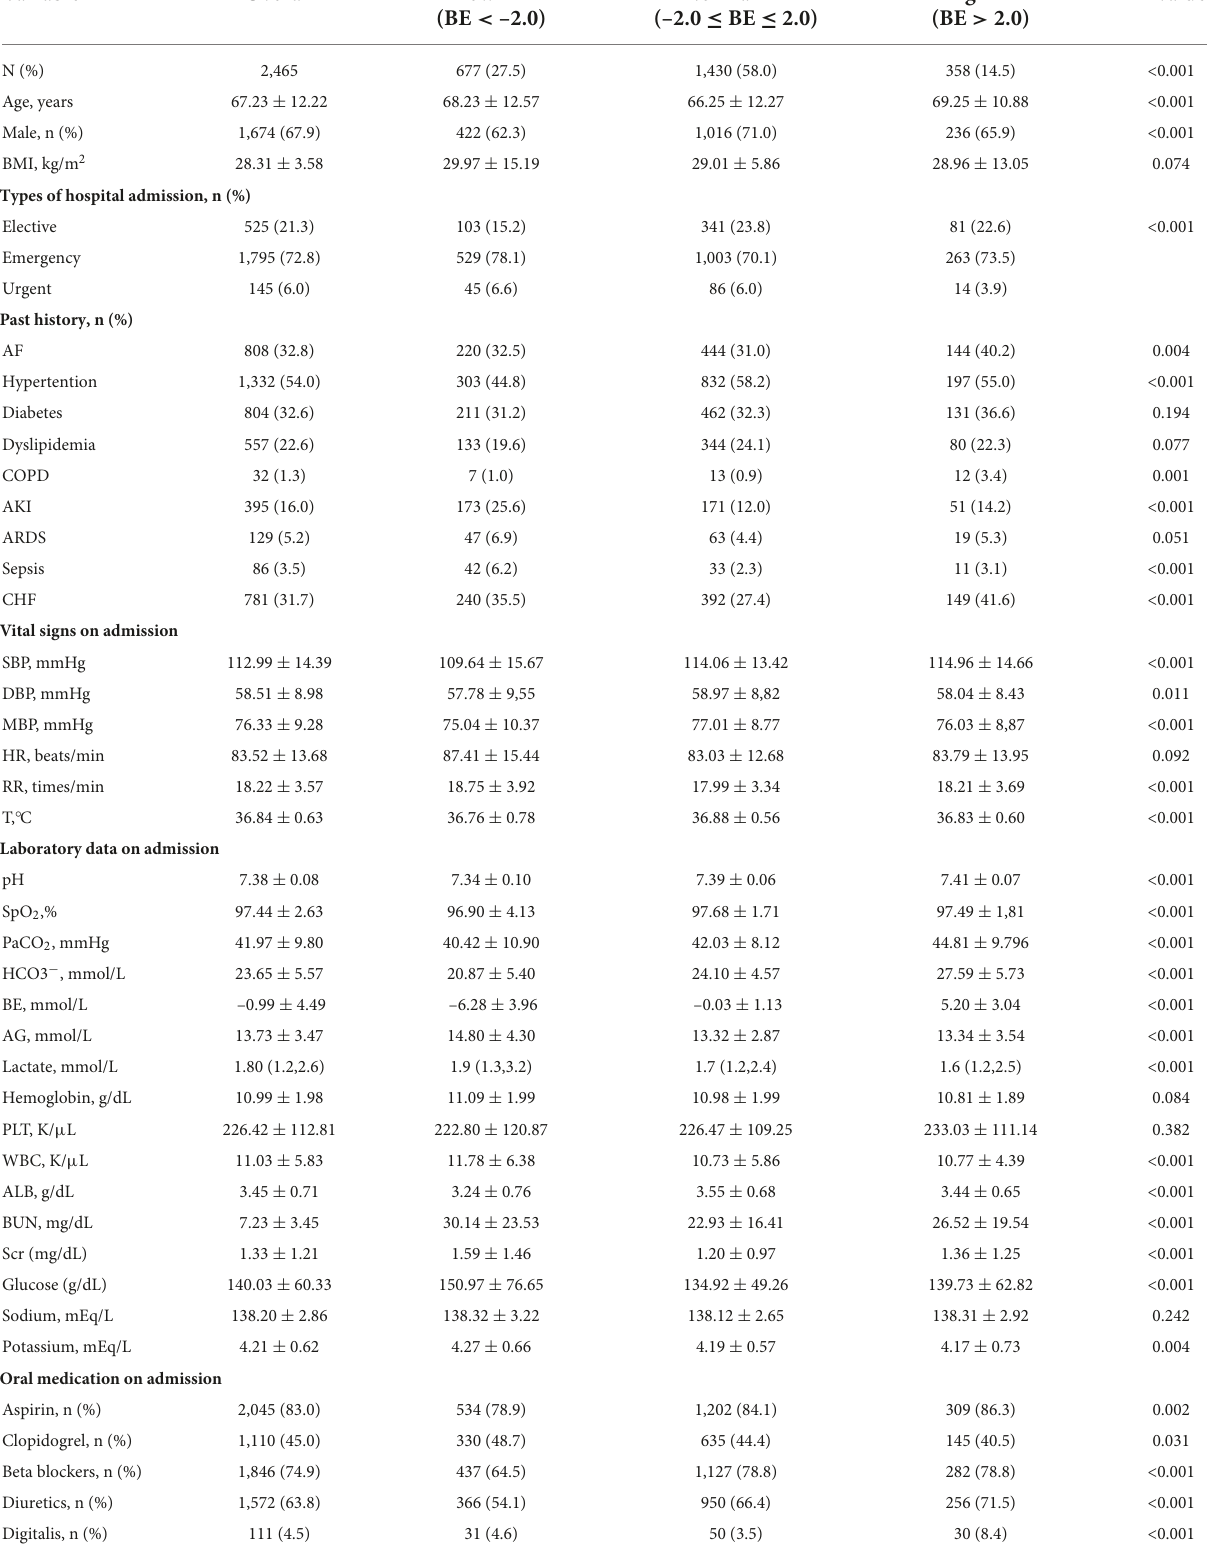
TABLE 1 Baseline characteristics across base excess values. Variable Overall Low BE